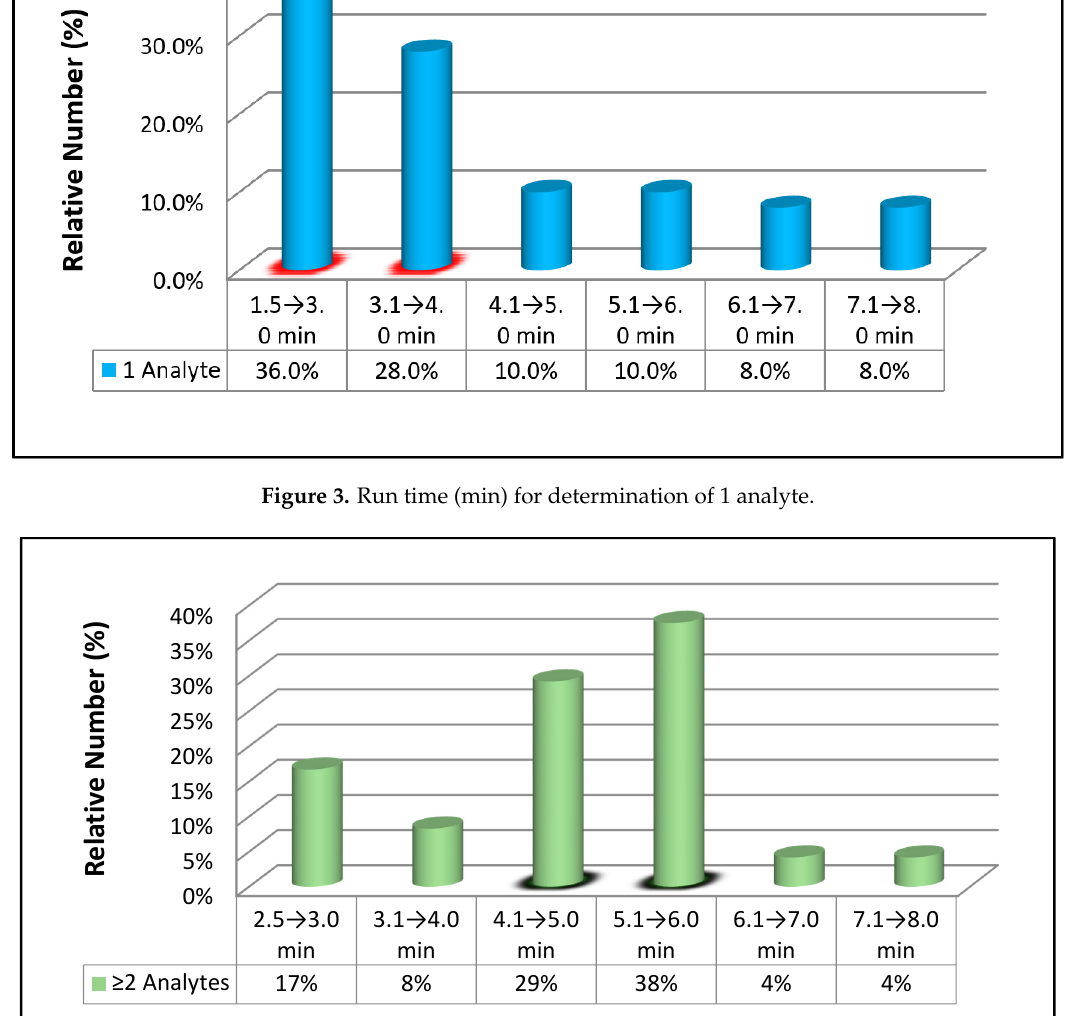
Figure 4. Run time (min) for determination of ≥ 2 analytes.